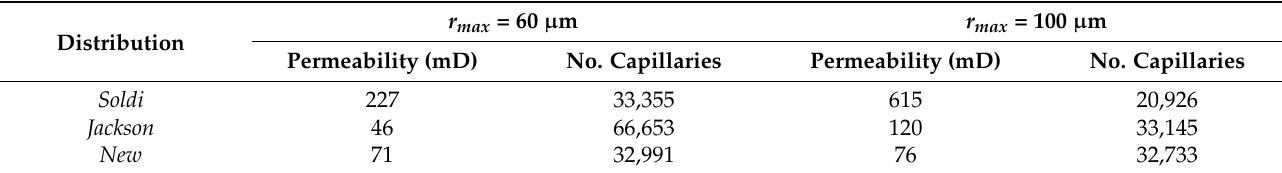
Table 5. Permeability and number of capillaries within the model for Soldi , Jackson and New distribution functions with alternating capillary radius and model porosity of 18.75% with radial and length factors of 0.7 and 0.2, respectively, when dr c = 0.1 µ m.